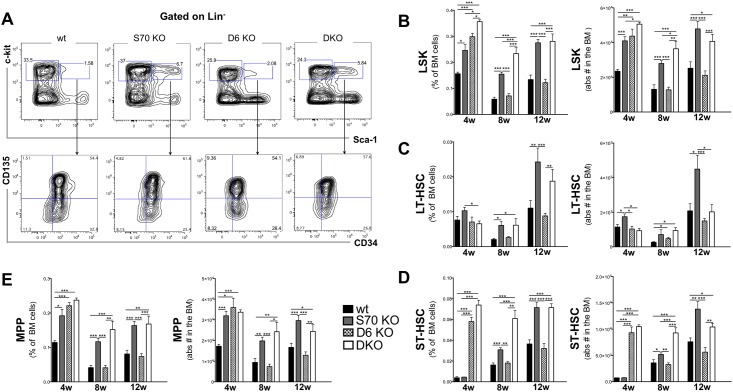
Hematopoietic stem cell and progenitor analysis in the bone marrow of Swap-70-/-, Def6-/- and double knock-out mice.(A) Representative FACS plots of freshly isolated BM from wt, Swap-70-/- (S70 KO), DEF6-/- (D6 KO) and Swap-70-/-DEF6-/- (DKO) 8-week old mice. Upper plots: subgated DAPI-Lin- BM cells. Percentages shown are of parental gate. Lower plots: subgated DAPI-Lin-kit+Sca+ (LSK) to discriminate long-term HSC (LT-HSC, CD34-CD135-), short-term HSC (ST-HSC, CD34+CD135-) and multiple progenitors (MPP, CD34+CD135+). Percentages shown are of parent LSK populations. (B) Relative (on the left) and absolute (on the right) LSK cell numbers in the BM of wt (black bars), SWAP-70 (grey bars) and DEF6 (dotted bars) single and DKO (white bars) of different ages (4, 8 and 12 weeks old) quantified by FACS. (C) Relative (on the left) and absolute (on the right) LT-HSC cell numbers in the BM of wt, SWAP-70 and DEF6 single and DKO of different ages quantified by FACS. (D) Relative (on the left) and absolute (on the right) ST-HSC cell numbers in the BM of wt (black bars), SWAP-70 (grey bars) and DEF6 (dotted bars) single and DKO (white bars) of different ages (4, 8 and 12 weeks old) quantified by FACS. (E) Relative (on the left) and absolute (on the right) MPP cell numbers in the BM of wt (black bars), SWAP-70 (grey bars) and DEF6 (dotted bars) single and DKO (white bars) of different ages (4, 8 and 12 weeks old) quantified by FACS. At least 5 mice of each genotype per group were analyzed, >8 mice 12 weeks of age were analyzed. Mean ± SD. *P<0.05, **P<0.01, ***P<0.005.